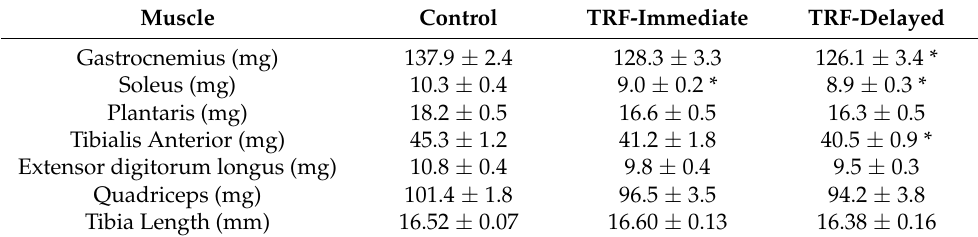
Table 2. Muscle mass.